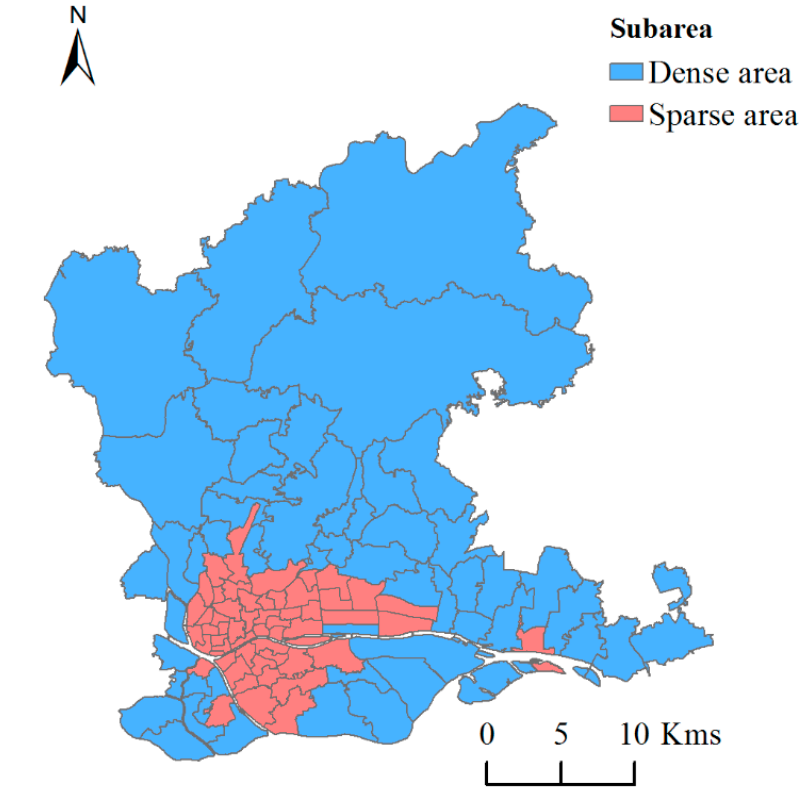
Figure 3. Zoning map of the research area based on population congregation.